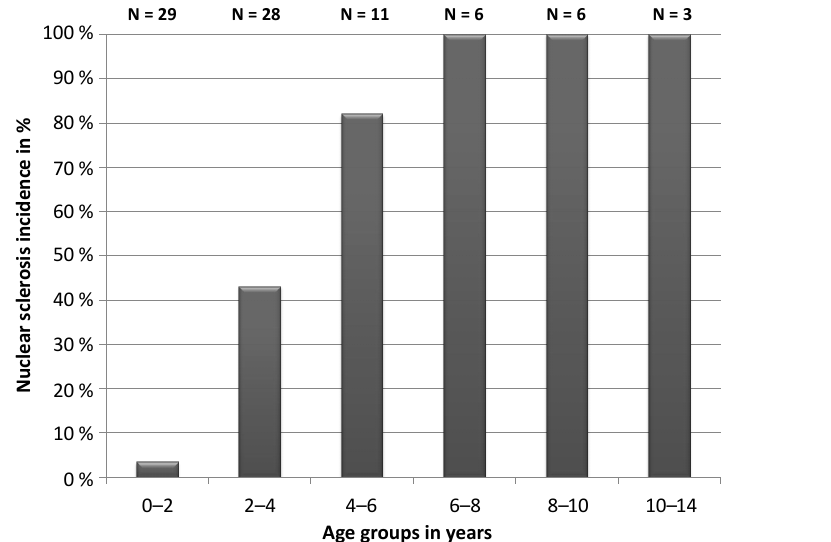
Figure 3. Incidence of nuclear sclerosis in different age categories of mouse lemurs. N is the number of all investigated animals per age